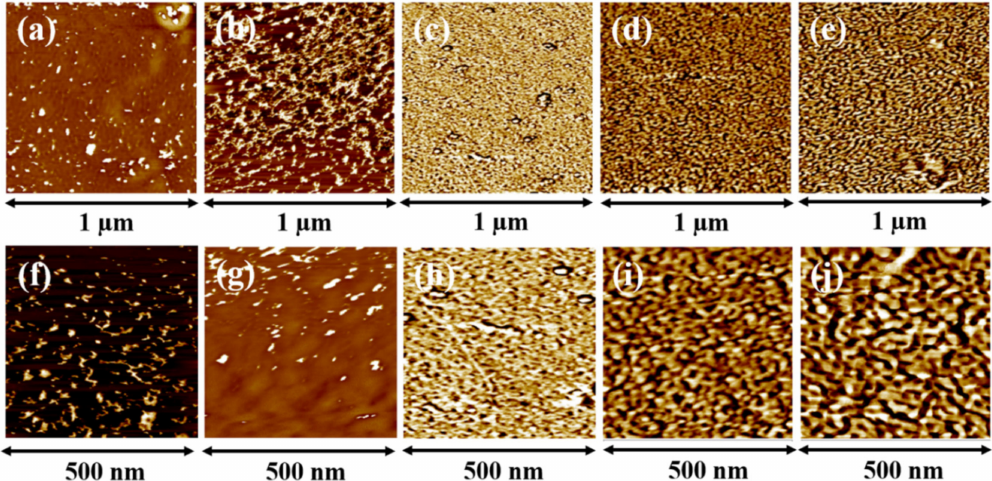
Figure 7. AFM phase images of ( a , f ) Q-PAES-10%, ( b , g ) Q-PAES-20%, ( c , h ) Q-PAES-30%, ( d , i ) Q-PAES-40%, ( e , j )